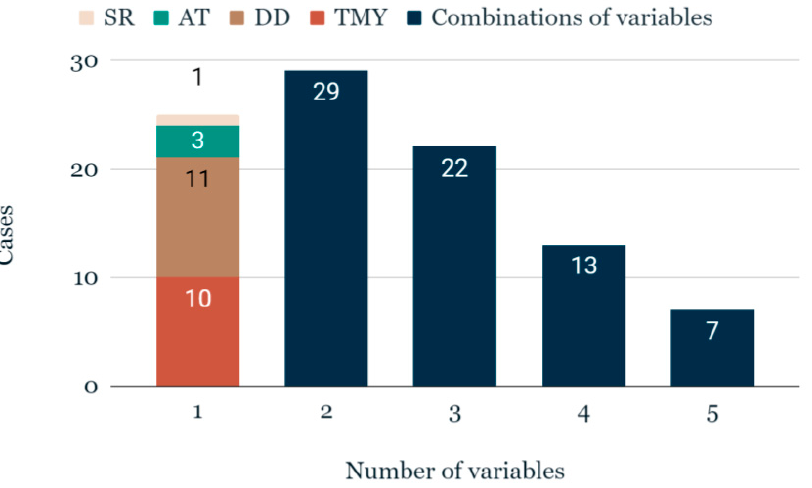
Figure 5. The number of climate variables used for CZB.